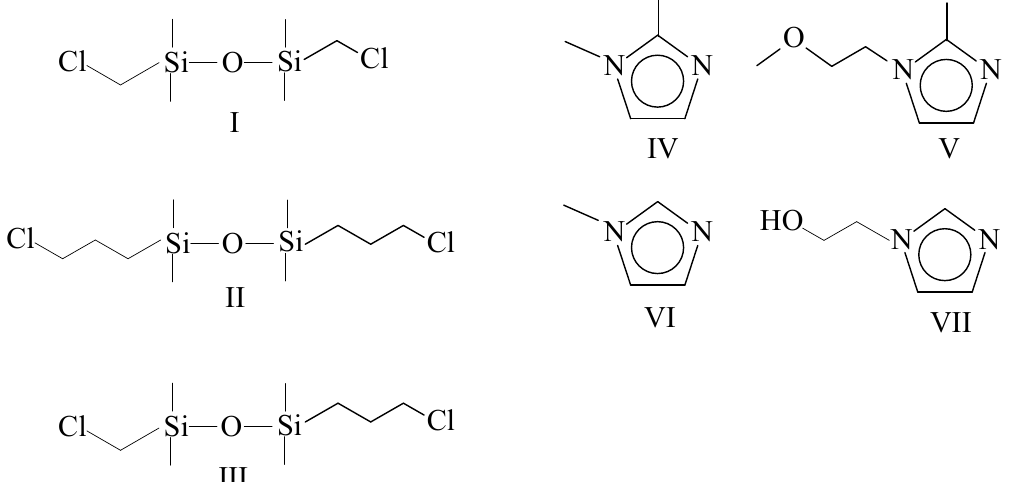
Figure 1. Di(chloroalkyl)tetramethyldisiloxanes and substituted imidazoles used for the synthesis of ionic liquids.